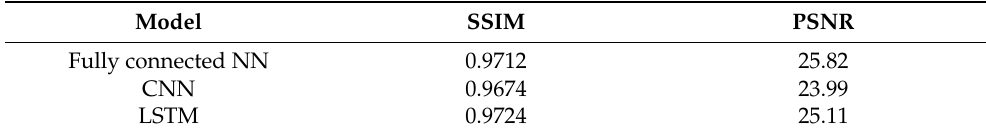
Table 5. The metrics of the models on the test set.